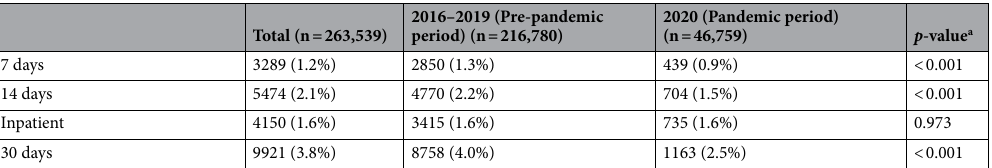
Table 1. Baseline characteristics of the validation population. a p-values were calculated using the t-test for continuous and the chi-square test for categorical variables to compare the 2016–2019 and 2020 cohorts. b Comorbidities were calculated for the consideration of the previous 5 years from the ER visit for each patient, and healthcare use was calculated using the previous 1 year.